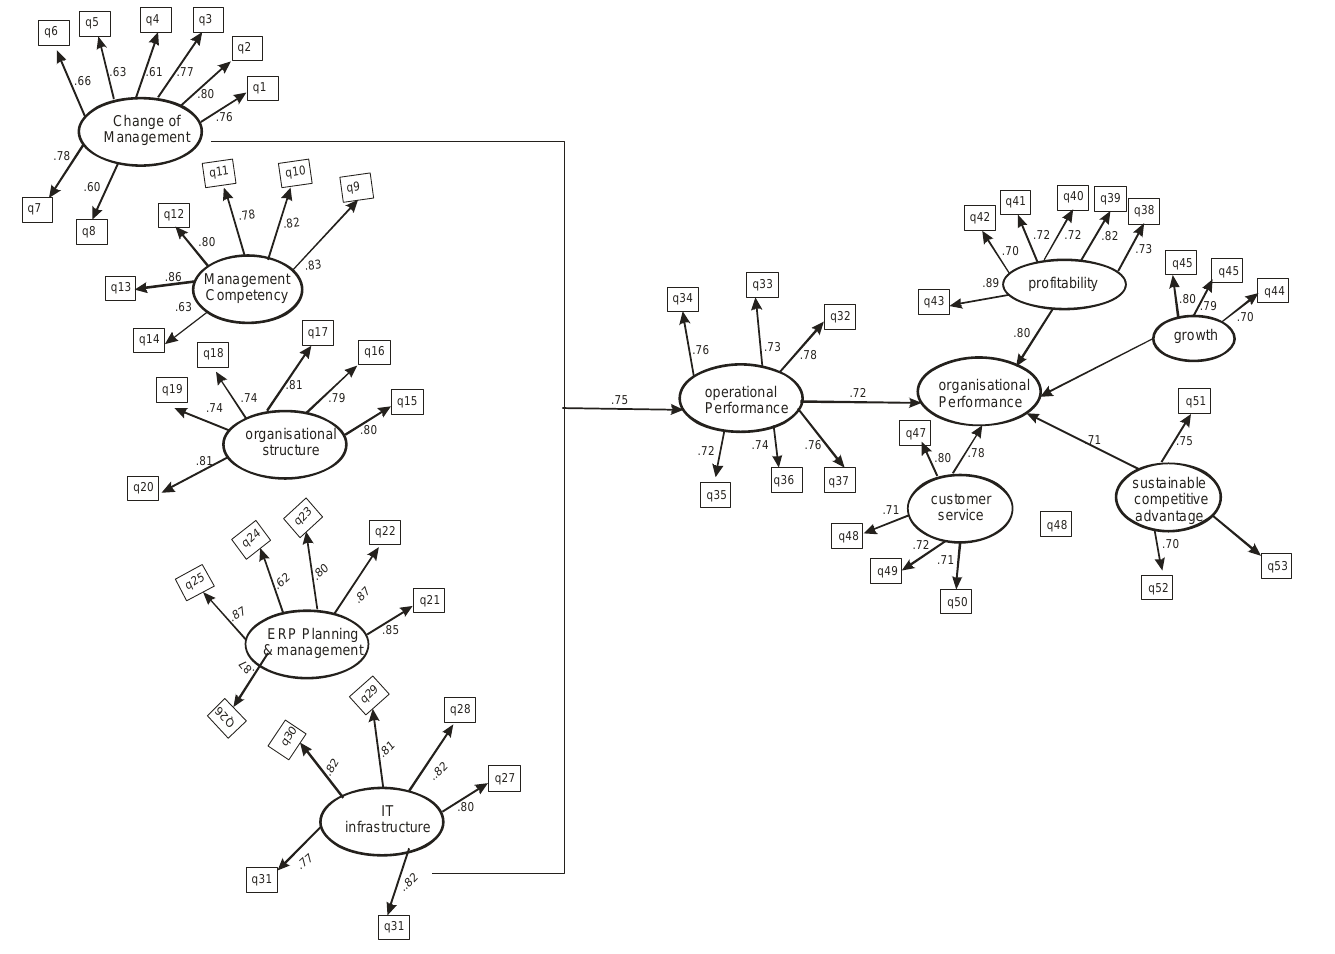
Figure 2: Structural equation modelling for path dependencies of the variables Multivariate analysis-regression